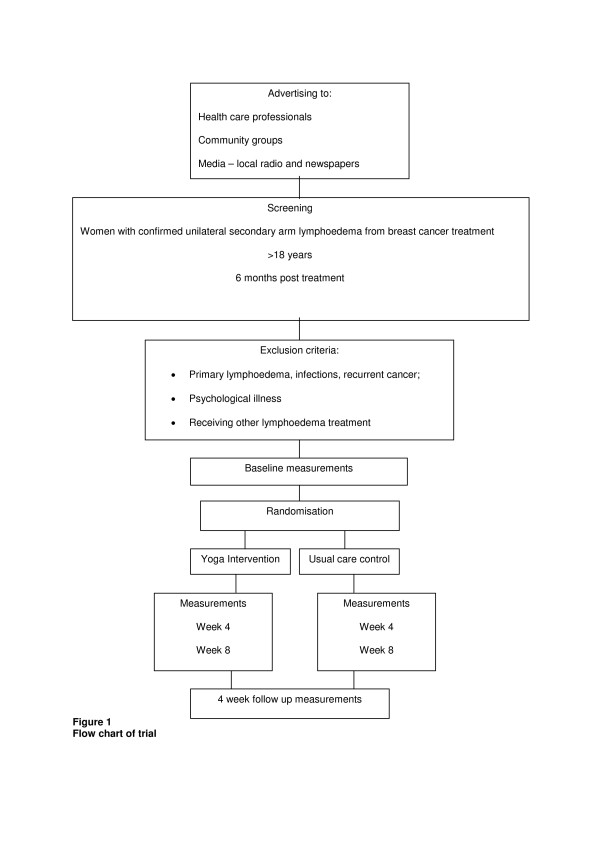
Flow chart of trial.